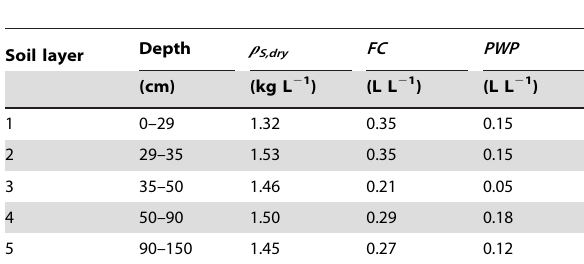
Table 4. Measured soil parameters (depth, dry density r S,dry , field capacity, FC, and permanent wilting point, PWP ) of the soil layers.